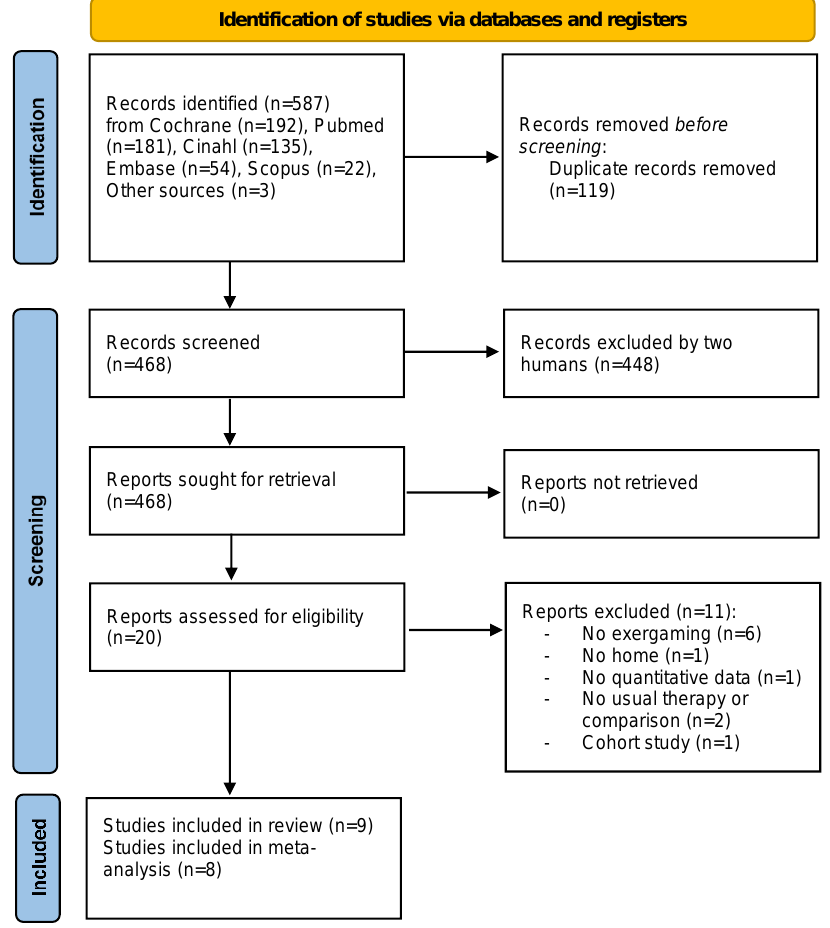
Figure 1. Prisma 2020 Flow Diagram [24].